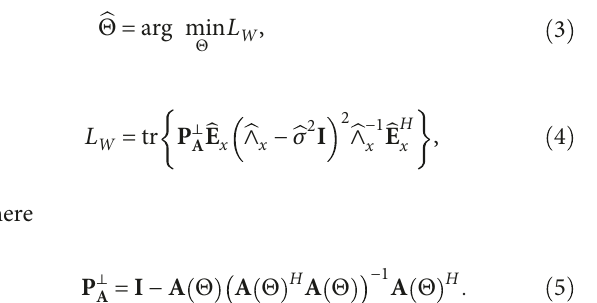
Algorithm 1. Genetic